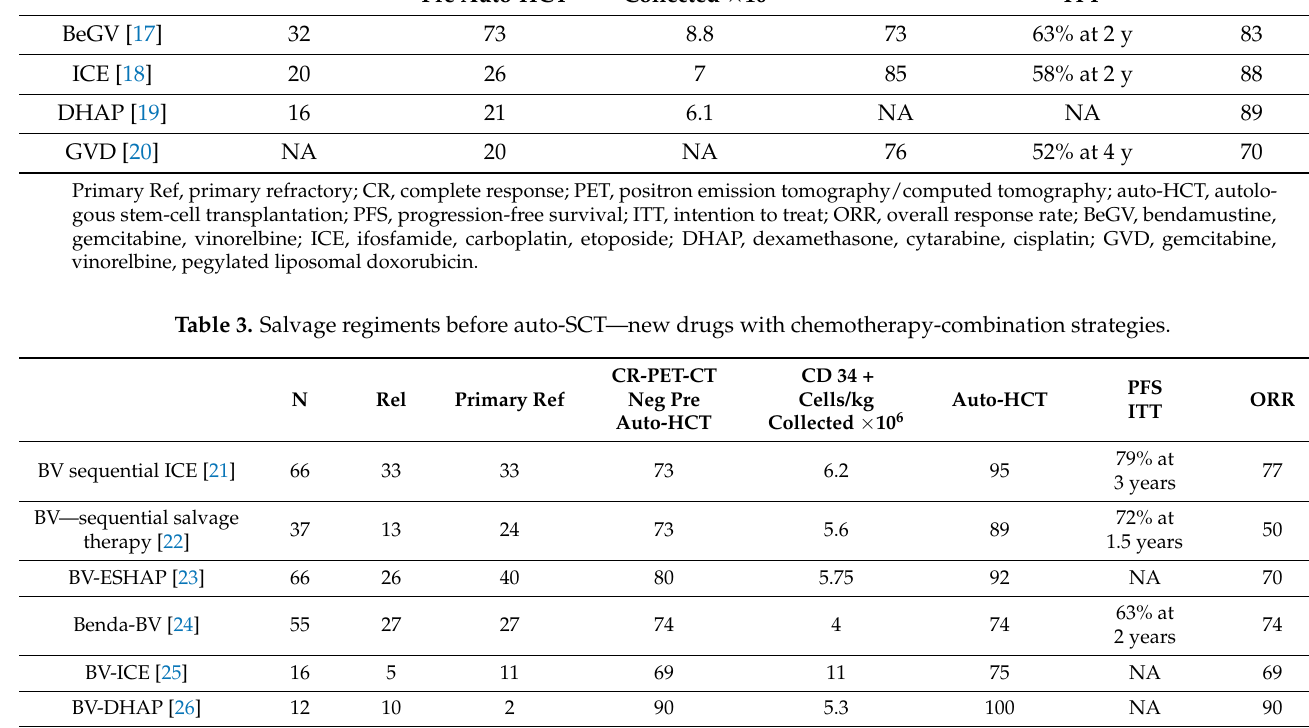
Table 2. Salvage regimens—conventional chemotherapy. Primary Ref.